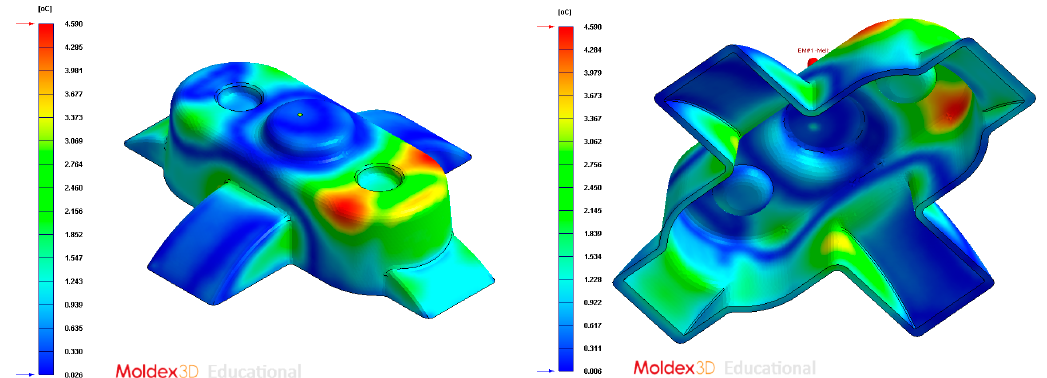
Figure 19. Gradient temperature ( ° C) on the mold surface after the cooling phase, Case A. Front view ( left ) and bottom view ( right ).